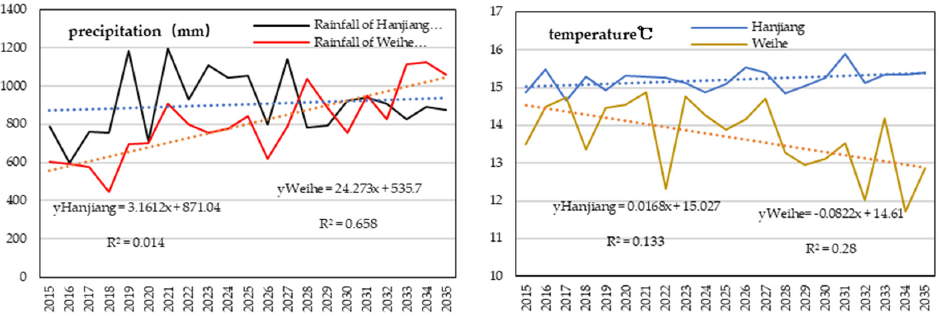
Figure 8. Future variation trend of precipitation and temperature in the Qinling Hanjiang River and Weihe River